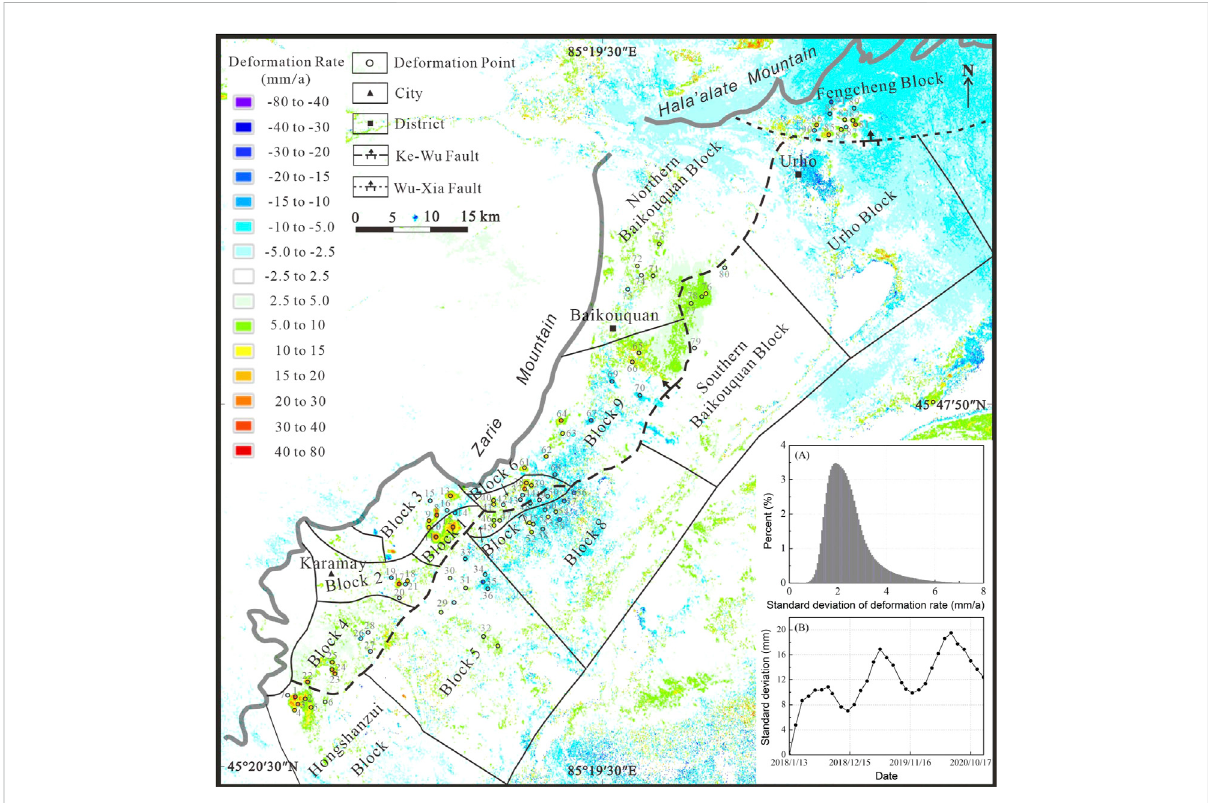
FIGURE 3 Deformation rate map in the line of sight (LOS) direction obtained by SBAS-InSAR processing from January 2018 to December 2020, in which (A) illustrates theprecisionof thedeformation ratecalculated bySARscape software, (B) shows thestandard deviation ofthesurfacedeformation on each SAR acquisition